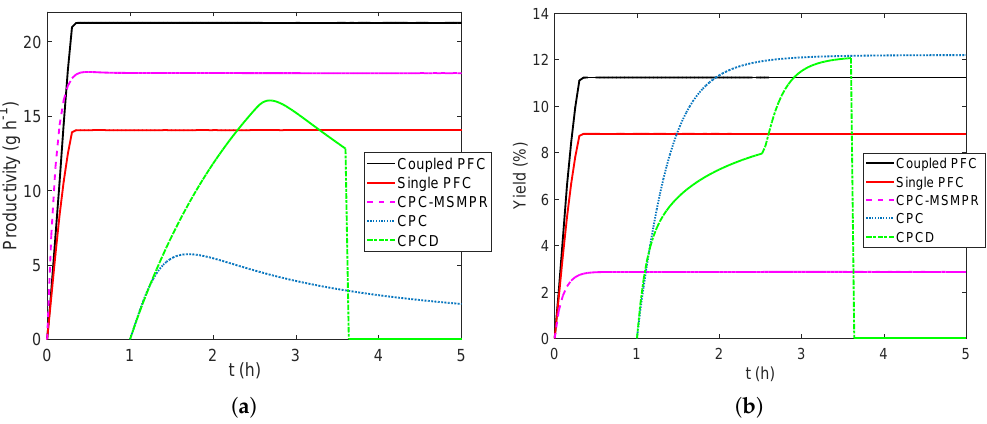
Figure 5. ( a ) Comparison of productivity and ( b ) comparison of yield for various process configurations (with purity ee S ≥ 99%). The process conditions used in PFC– feed flow rate 25 mL min − 1 , liquid phase exchange rate 12.5 mL min − 1 , exchange of liquid introduced at the midpoint along the crystallizer length (i.e., at the inlet of segment 4), seed mas 2 g per 0.45 L of slurry, the cooling in the PFC is from 36 ◦ C to 30 ◦